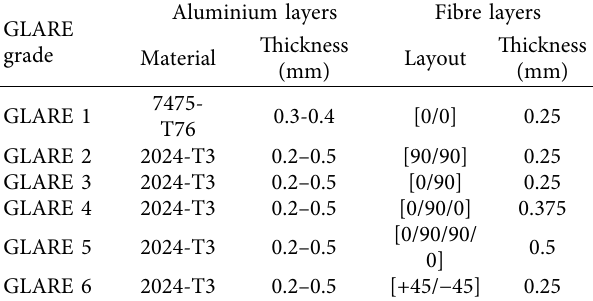
Table 1: Commercially available GLARE grades [3]. GLARE